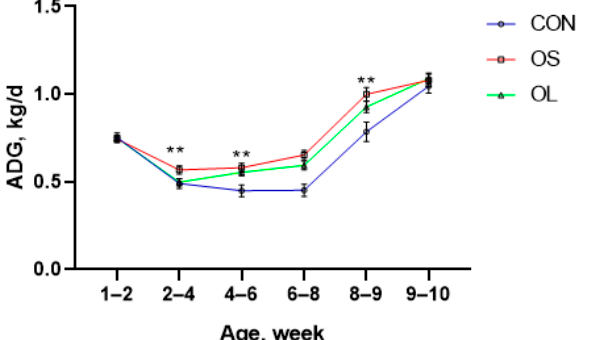
Figure 2. Mean ADG for Holstein female calves fed a basic diet without hay (CON: empty circles; red line) and inclusion of short oat hay (OS: 3–5 cm, empty squares; green line) or inclusion of long oat hay (OL: 10–12 cm, empty triangles; blue line). Differences between CON with hay are represented by an asterisk ( p < 0.05, denoted by **).